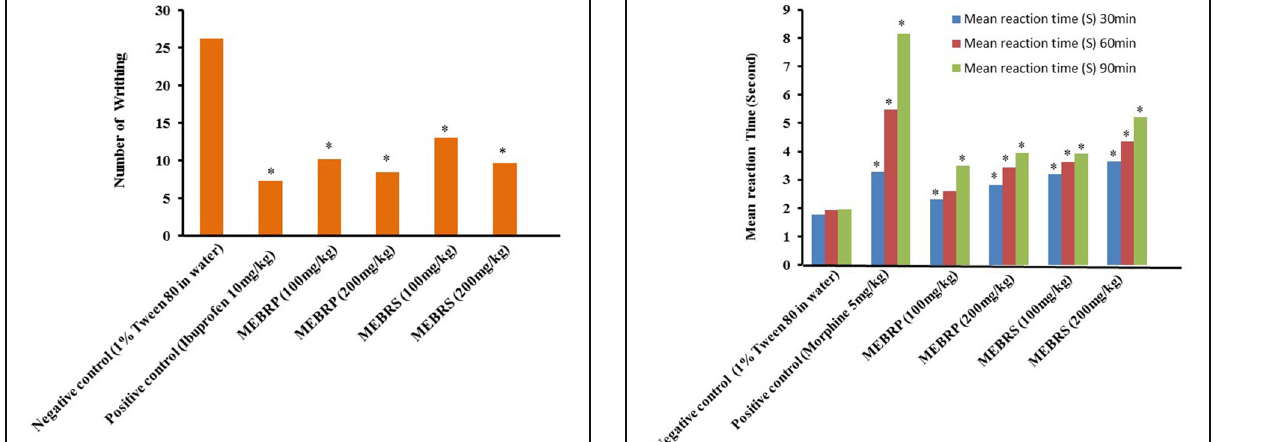
Fig. 1 Analgesic effects of methanol extract of the Baccaurea ramiflora pulp and seed on acetic acid-induced writhing in mice. Values are means ± SEM of five mice ( n =5); * p <0.05 as compared to control (One way ANOVA followed by Dunnett ’ s test). Control mice received vehicle (1% Tween 80 in water), positive control received Ibuprofen 10 mg/kg body weight, tested animals were treated with 100 and 200 mg/kg body weight (p.o.) of the MEBRP and MEBRS, respectively